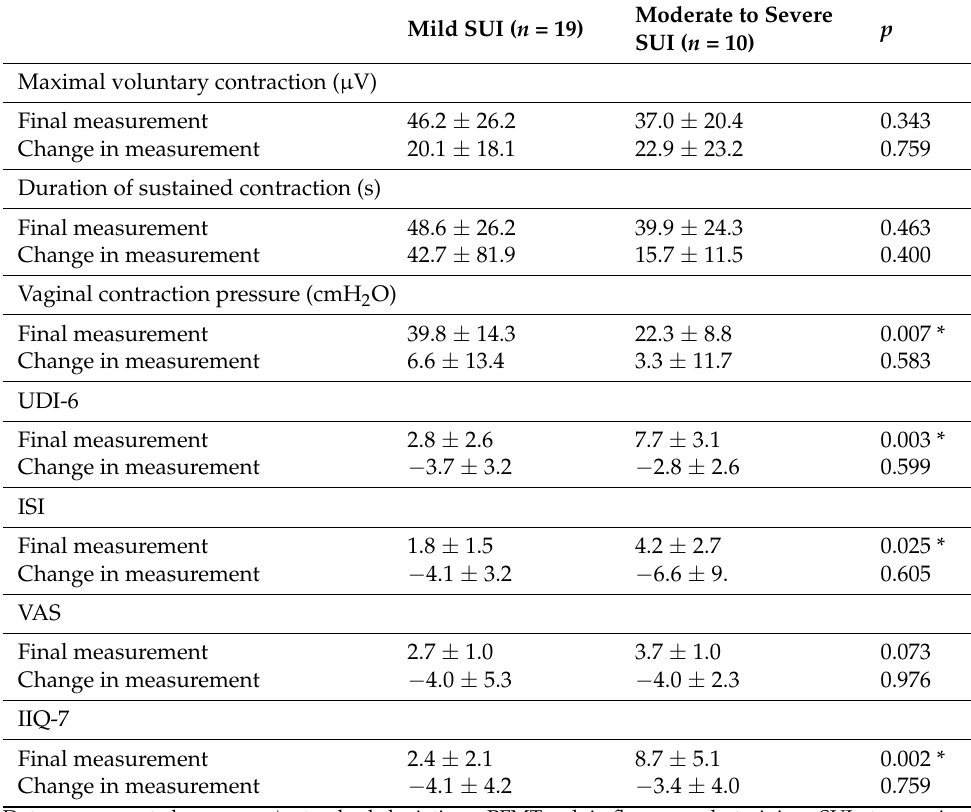
Table 3. Outcomes after completing 18 sessions of biofeedback and electrostimulation-assisted PFMT. Mild SUI ( n =